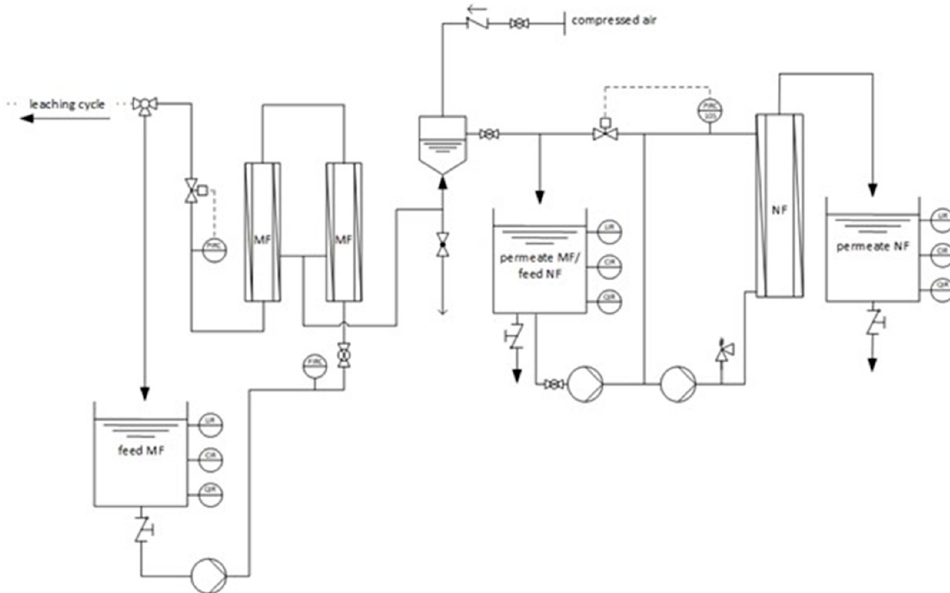
Figure 4. Flow sheet of the membrane pilot plant.